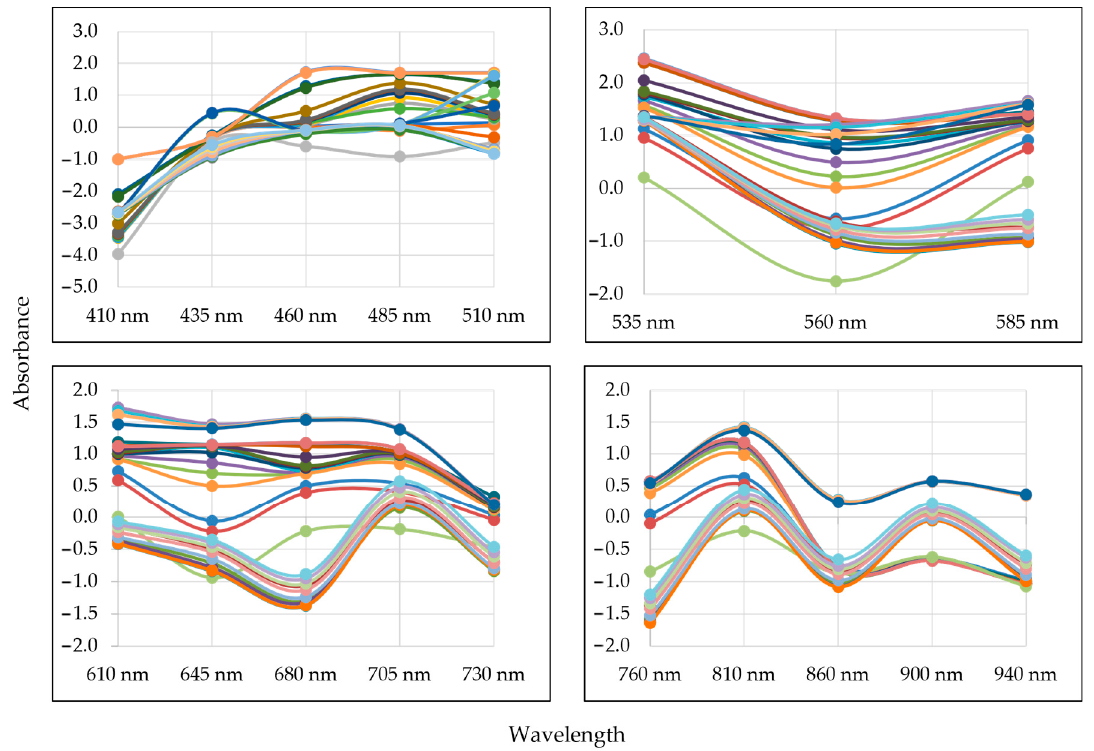
Figure 9. Tank L spectral absorbance rates over 28 days, plotted by wavelength.